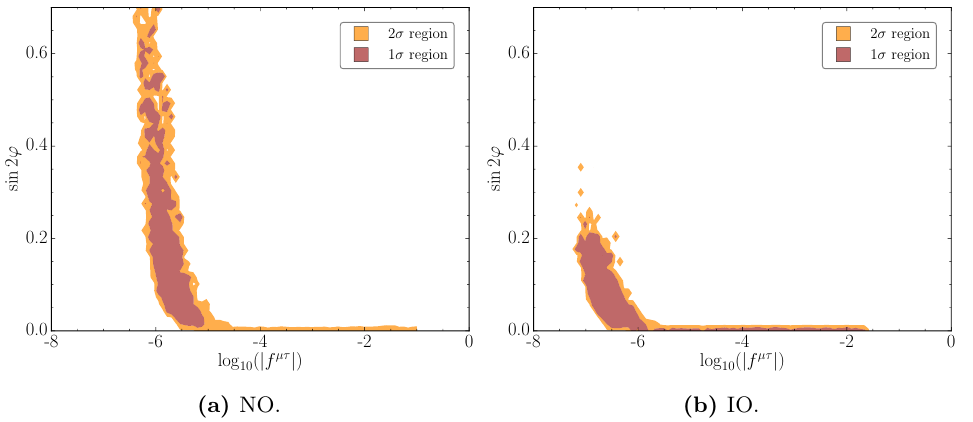
and Y (cid:28)(cid:22) for (a) NO and (b) IO. 2 2